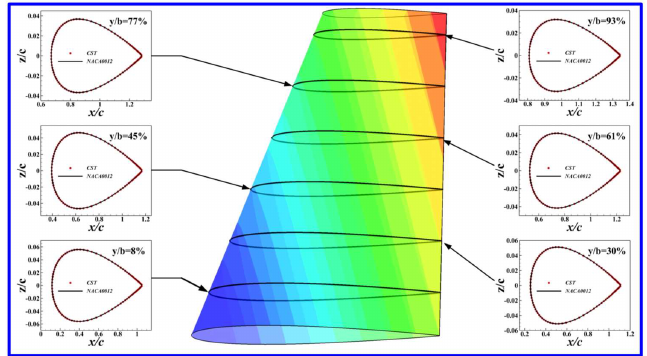
= 𝟗 ); ( c ) n = 4, m = 2 ( 𝑵𝒖𝒎 𝒃 𝒊,𝒋